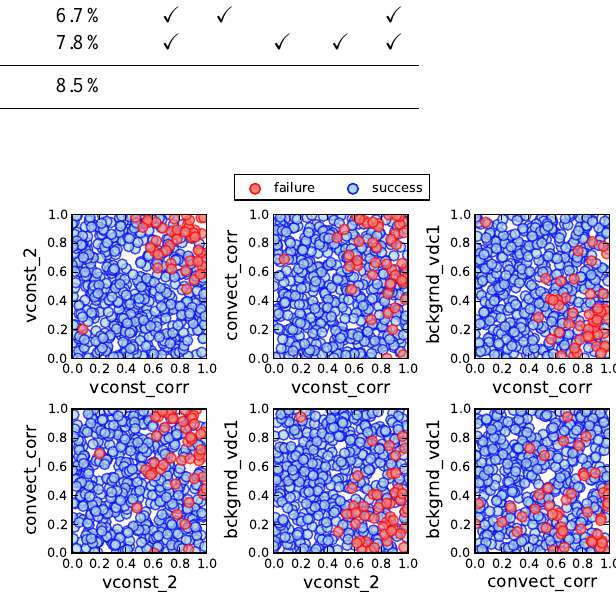
Table 2. Latin Hypercube Studies of the CCSM4 Parallel Ocean Program. Study Simulations Successes Failures Failure rate Data used in Section